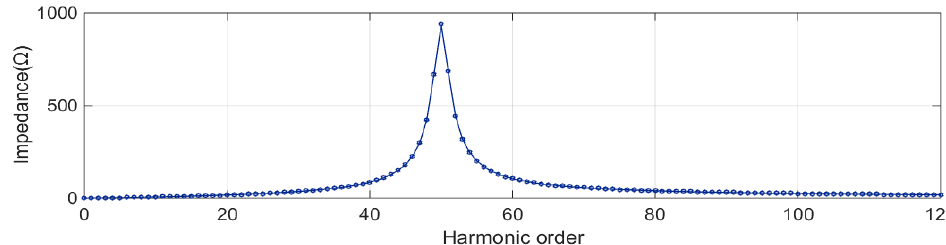
Figure 20. Impedance characteristic diagram of the resonant circuit.